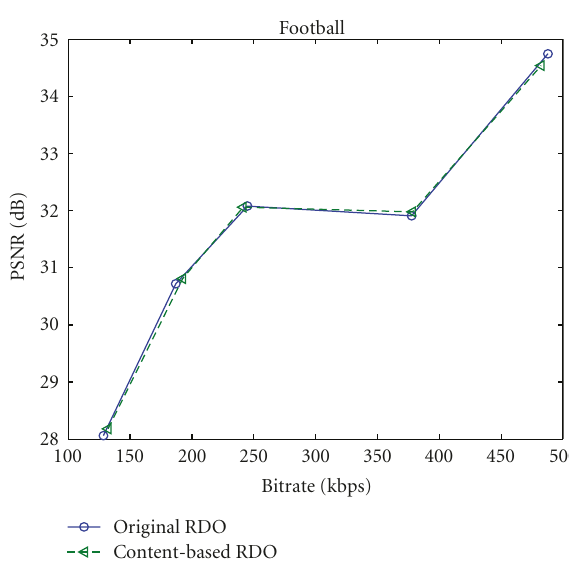
Figure 4: Comparison of PSNR results between the reference software and the proposed scheme for “Bus.”